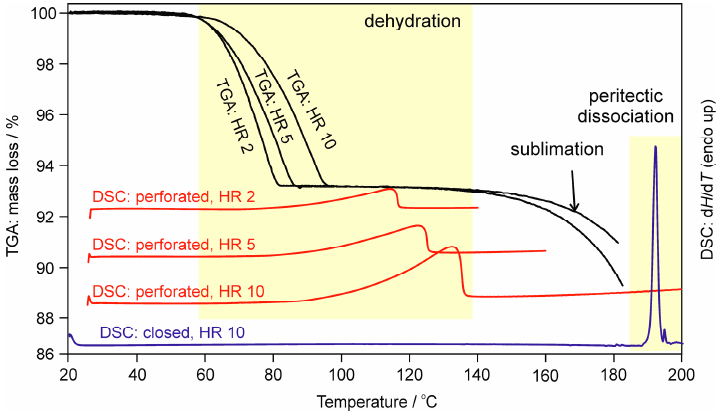
Figure 5. DSC and TGA thermograms of 2-Hy3 . Numbers correspond to heating rates in °C min − 1 .